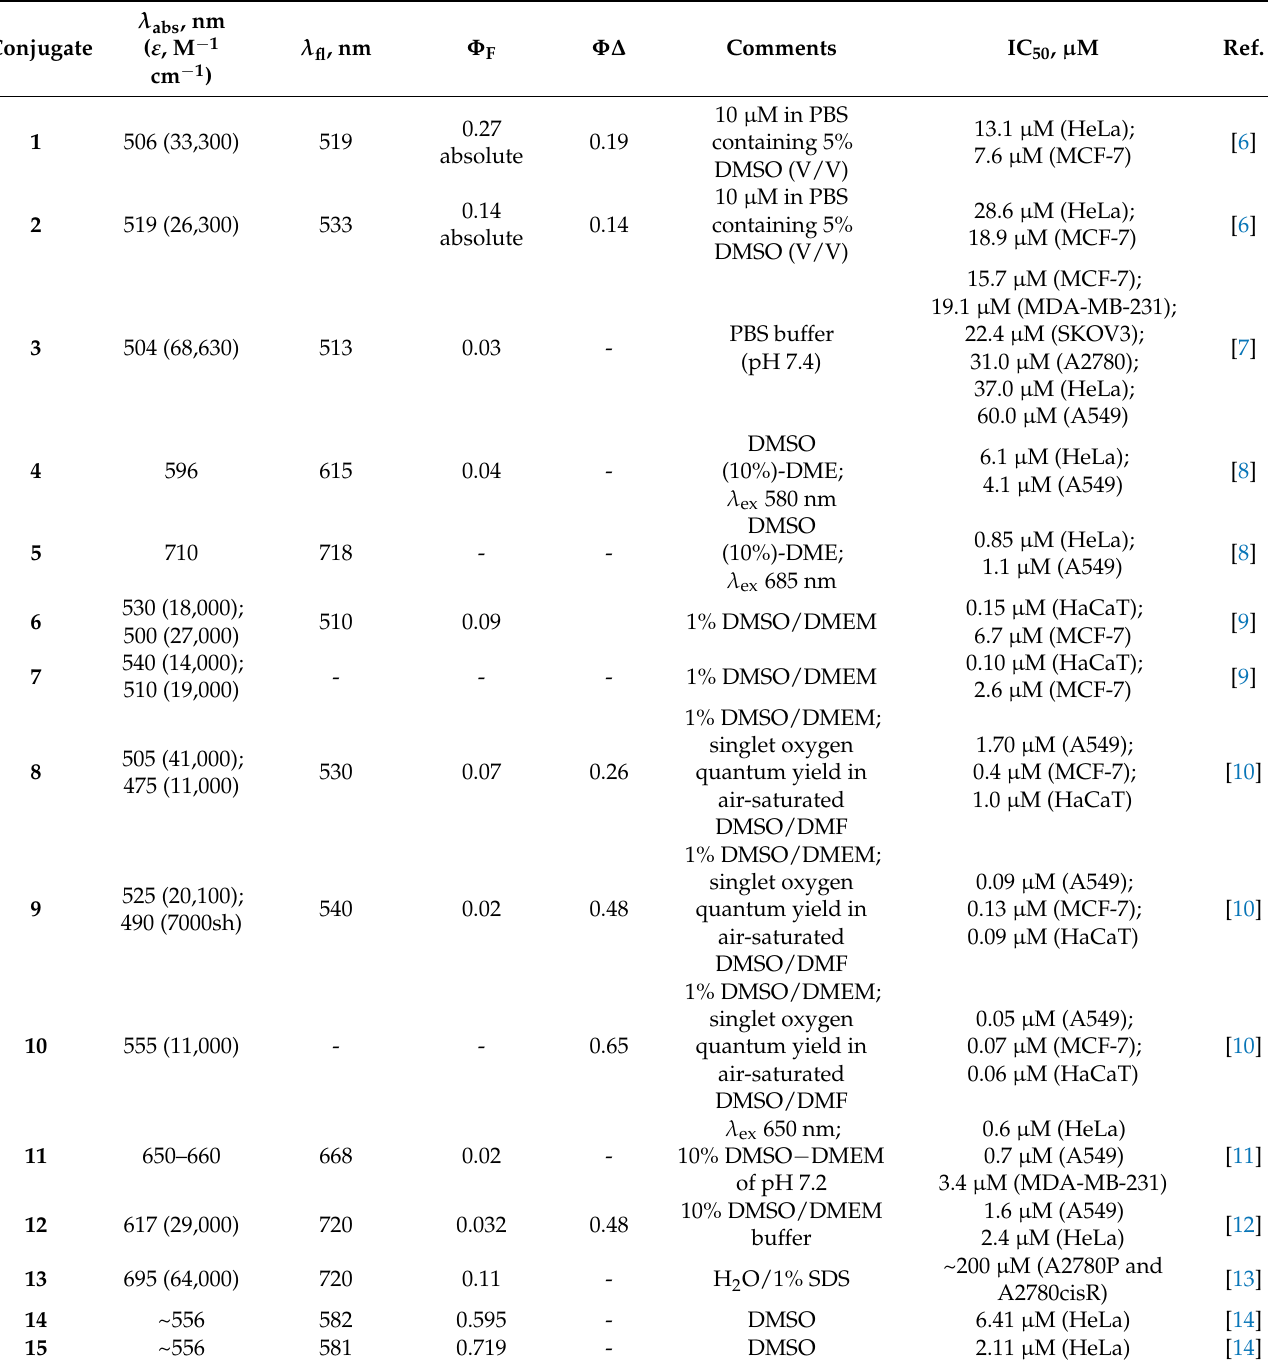
Table 1. Practically significant characteristics of BODIPY conjugates with platinum